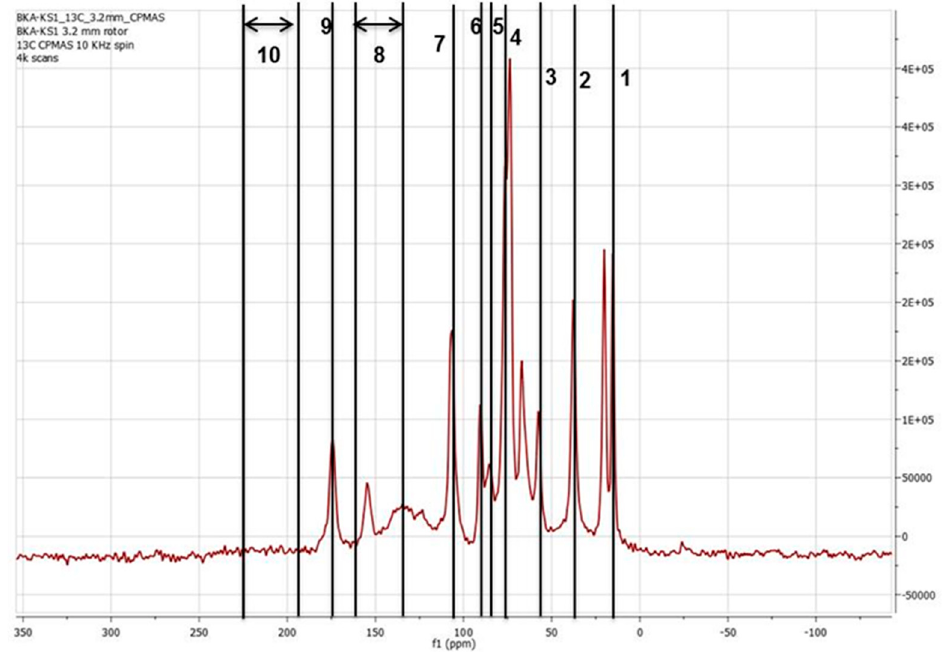
Figure 1. 13 C CP / MAS NMR spectra of butyrated biorefinery lignin (BL). Description of Figure 1. 13 C CP/MAS NMR spectra of butyrated biorefinery lignin (BL). Description of components / linkages are as follows: 1 → 21–24 ppm (CH 3 in acetyl groups in hemicellulose); 2 → 30–40